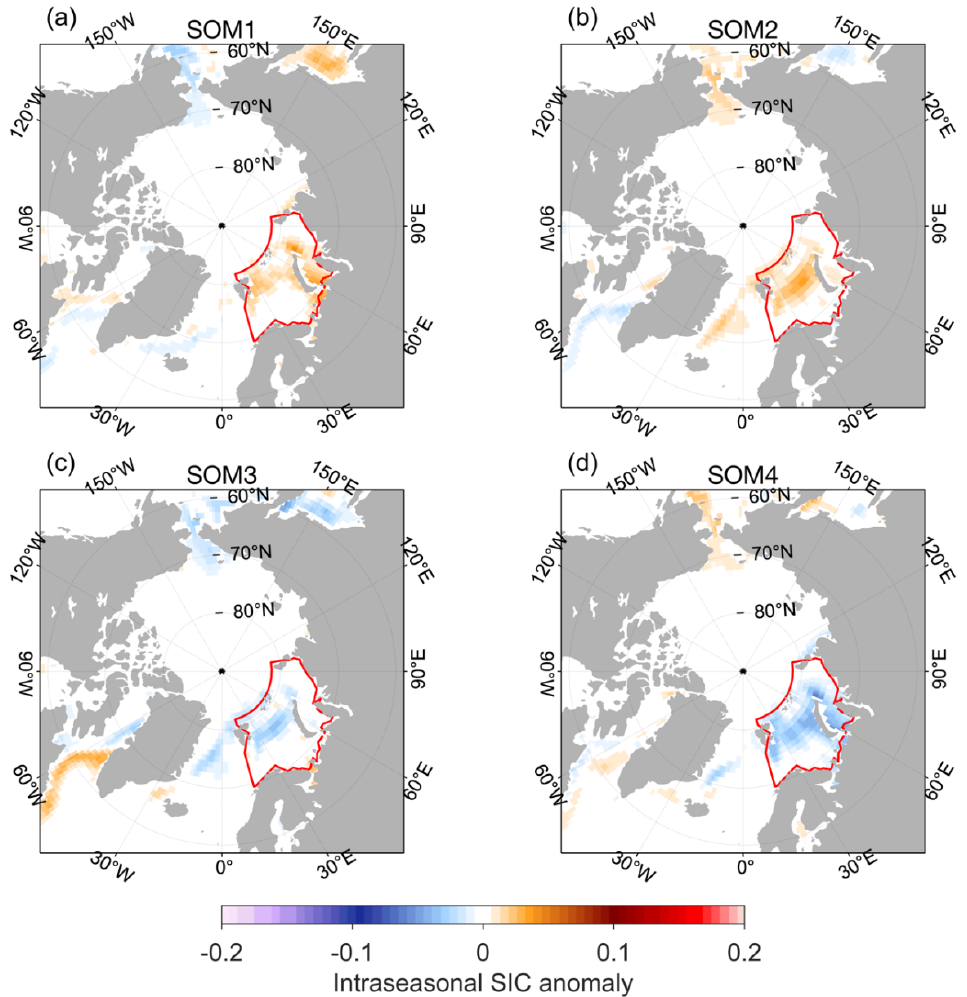
Figure 9. The same as Figure 7 except for the composites of the intraseasonal SIC anomalies. The four plots are intraseasonal SIC anomalies related to SOM1 ( a ), SOM2 ( b ), SOM3 ( c ), and SOM4 ( d